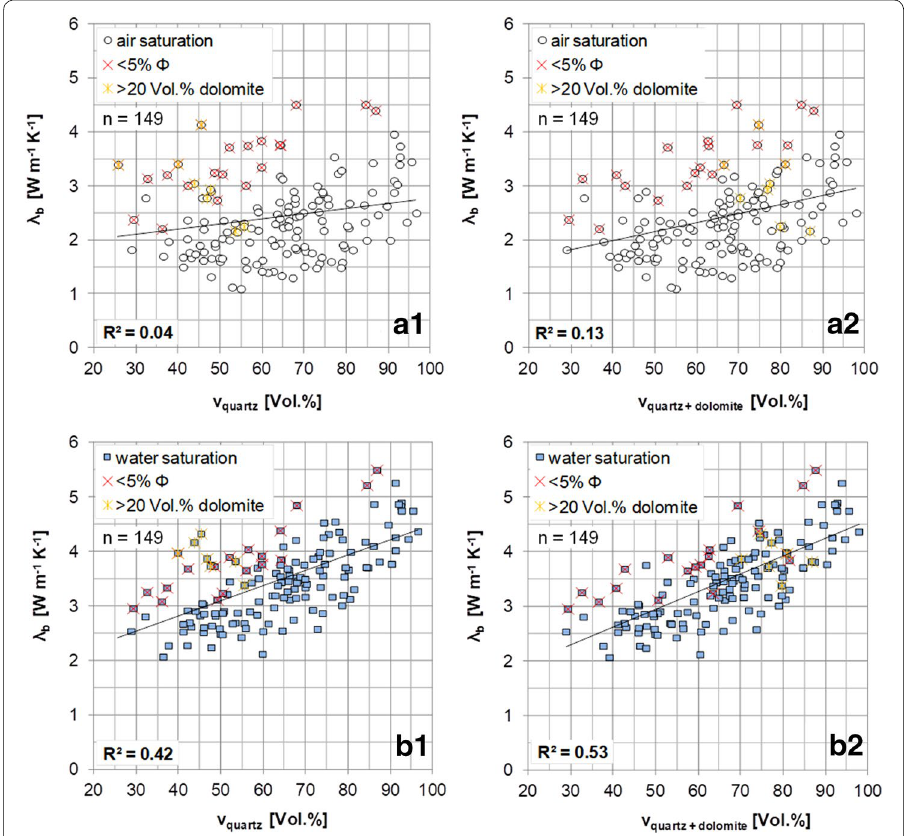
Fig. 10 Cross-plots illustrating the impact of particular minerals on measured λ b values. a1 Correlation of RVA total quartz (vol.%) and a2 of RVA total quartz dolomite (vol.%) with bulk thermal conductivities ( λ b ) of + air-saturated sandstone samples. b1 and b2 same as above, but for water-saturated sandstone samples. λ b is always measured parallel to bedding. Samples characterized by < 5% Φ and samples with > 20 vol.% dolomite are highlighted as they plot as